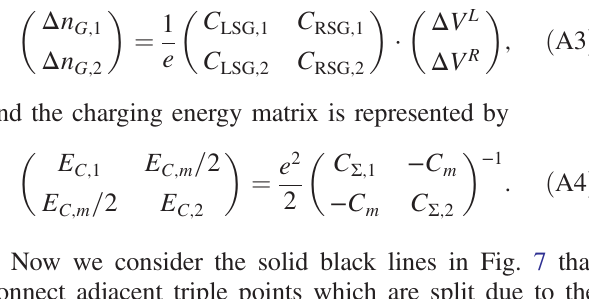
FIG. 6. Parameter comparison between the 11 configurations analyzed in the main text. (a) DQD capacitances C Σ (b) Dipole strength η . (c) κ and κ , extracted by fitting the reflectance of the bare SQUID array to a Lorentzian with the DQD deep in ext int Coulomb blockade. (d) Interdot tunneling rates Δ =h obtained from the JC model [see dashed lines in Figs. 3(a) – 3(c)]. In (c), the data are ordered according to the resonator frequency. In the remaining panels, the x axis is the configuration index.